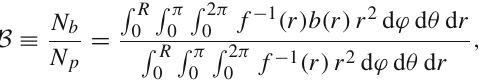
Fig. 14 The local trapping efficiency coefficient b for R / M = 2 . 4 is plotted for several values of j and θ . The solid line shows the local trap- ping for a non-rotating configuration and the dashed line shows local trapping for the rotating case. For the latter, the points above the dashed line are values for just counter-rotating directions of the null geodesics,